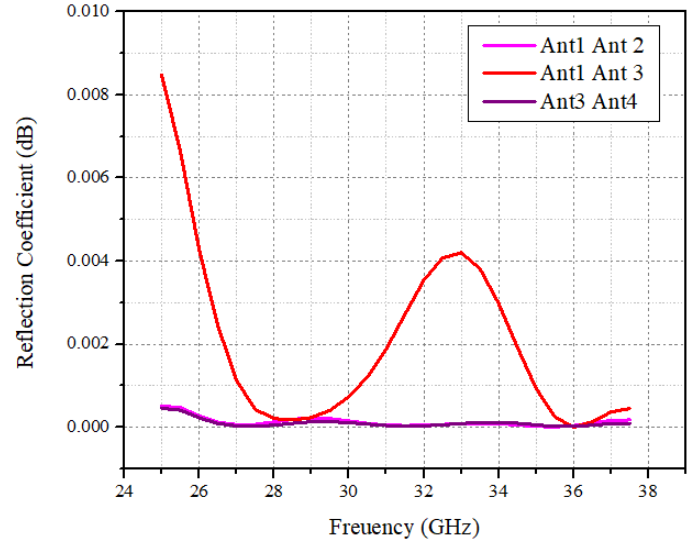
Figure 11. ECC derived.